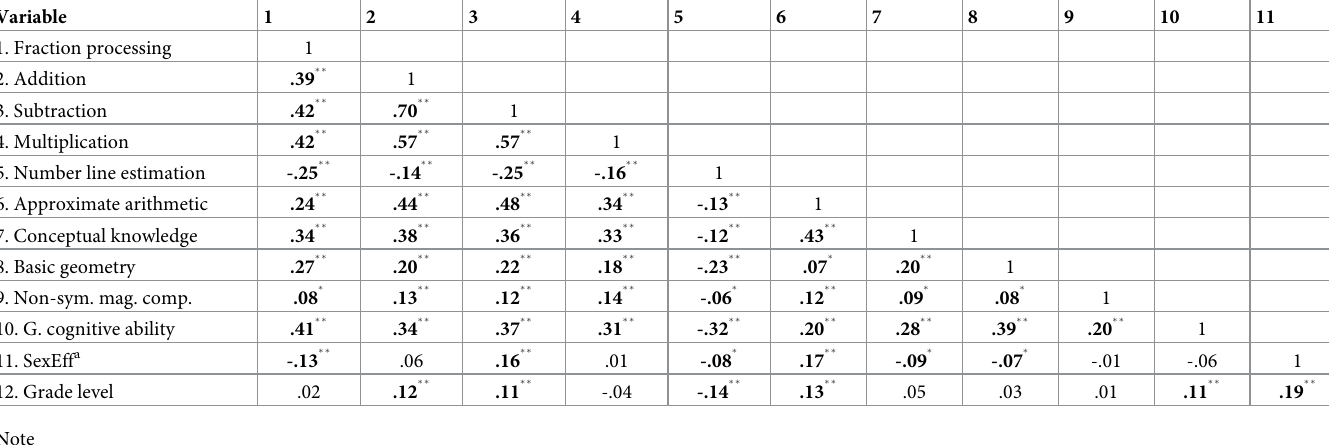
Table 2. Correlations between fraction processing, basic numerical skills, general cognitive ability, as well as sex and grade level. Variable